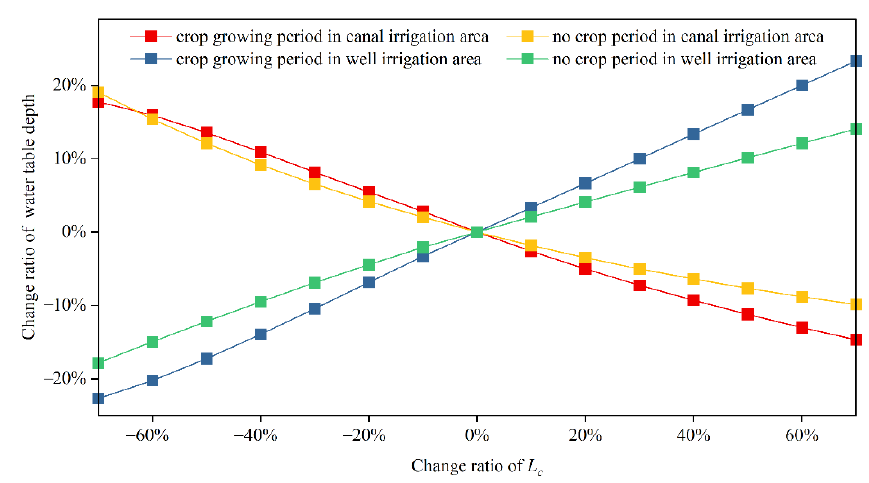
Figure 6. Sensitivity analysis of the characteristic length L c .